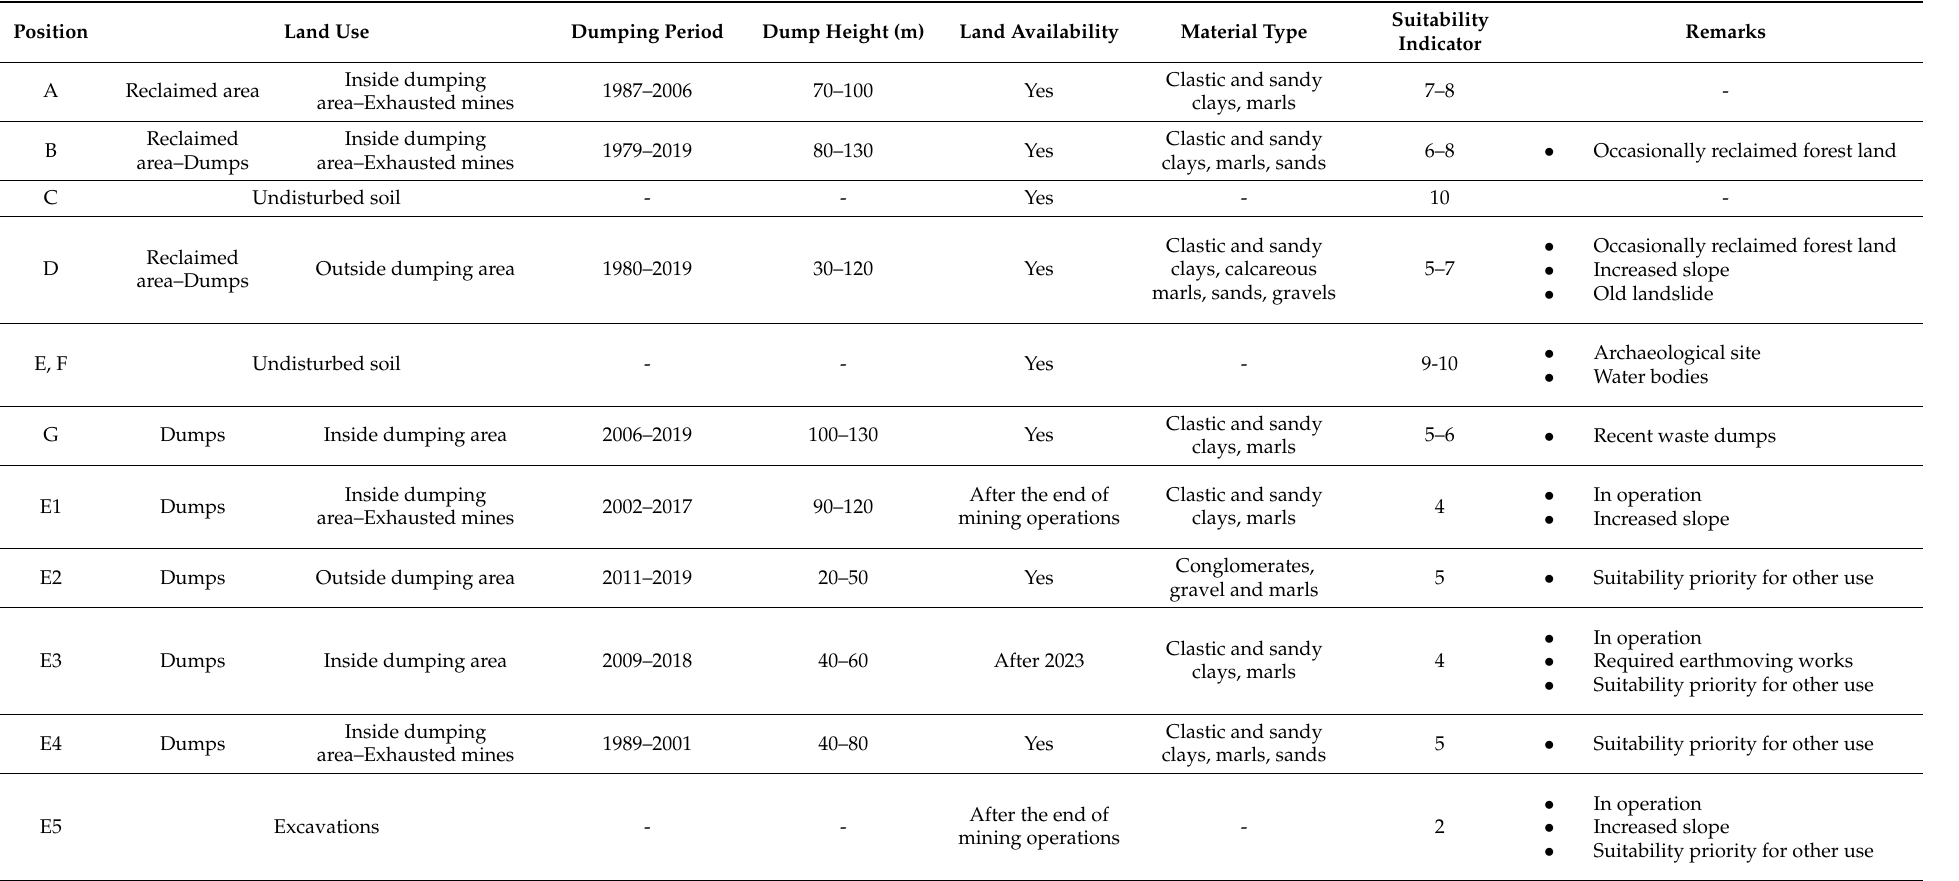
Table 1. Suitability assessment of PV park